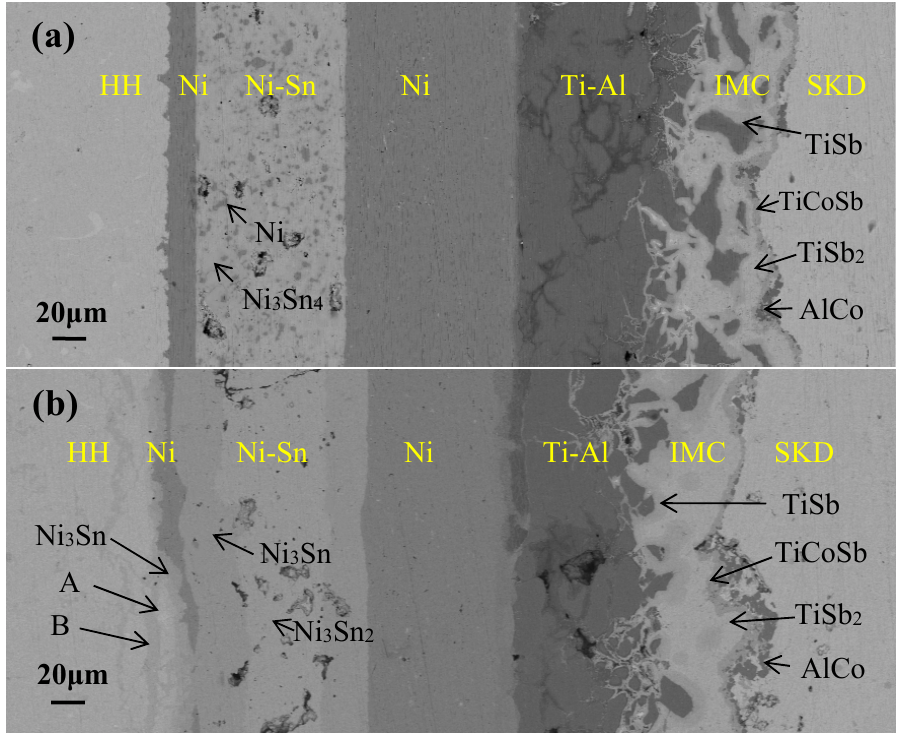
Figure 1. SEM (scanning electron microscopy) image of the microstructure across the joint interfaces before ( a ) and after ( b ) isothermal aging at 600 °C for 168 h. A and B denote Hf and Zr substituted Ni 3 Sn, and Ni riched HH, respectively.